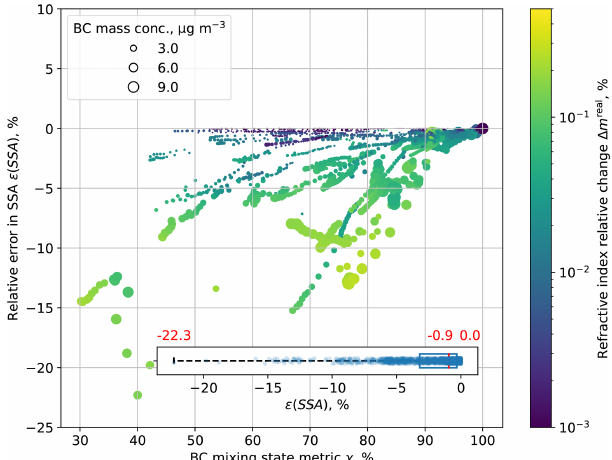
Figure 9. Same as Fig. 6a but for (cid:15) (SSA). Red numbers in the inset box plot are for the minimum, median and maximum